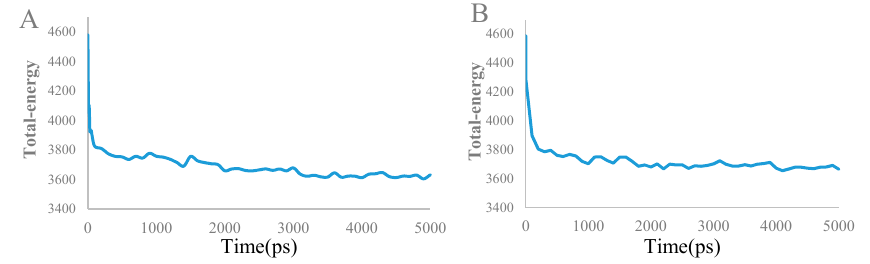
Figure 11. Plot of the total-energy docked complex (compound 28 ( A ) and compound 17 ( B )) and the molecular dynamics simulation time (ps) in the molecular dynamics simulated structure.